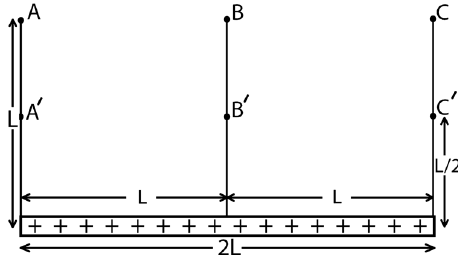
FIG. 5. A schematic diagram for the pretest questions (1) and